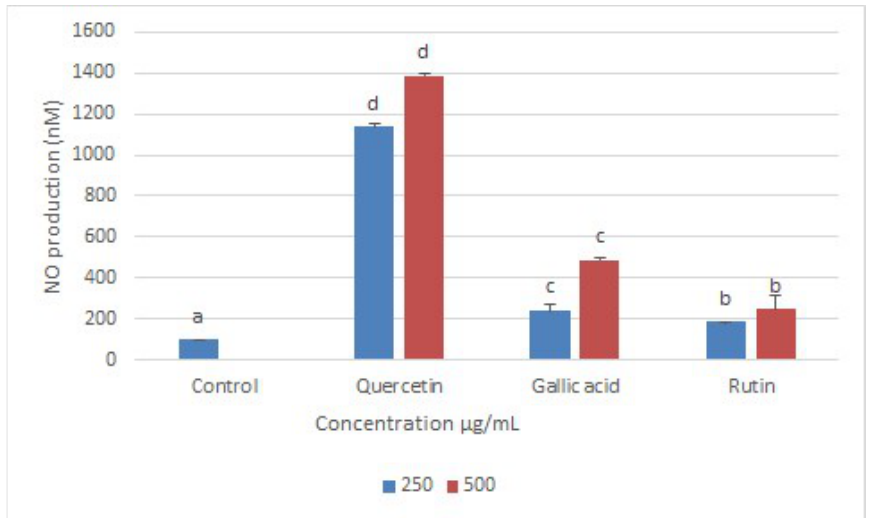
Figure 9. Quantification of NO production by BMDMs infected with L. donovani and treated with Q, GA, and R at 250 µg/mL and 500 µg/mL for 72 h. Infected macrophages without treatment served as a control. Data represent the mean values of three replicates with ± standard error. Different labels on columns show significant difference at p < 0.05.